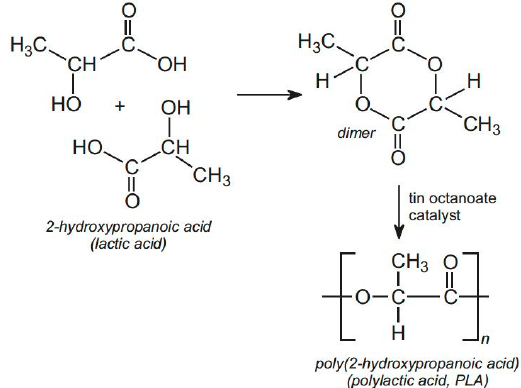
Figure 1. Polymerization of lactic acid to produce polylactic acid (PLA). Lactic acid cannot be polymerized directly as the water produced prevents the polymerization process. The acid is therefore first dimerized by heating and afterwards dimer undergoes ring opening polymerization using tin octanoate as a catalyst. This method avoids the formation of water during polymerization [7].